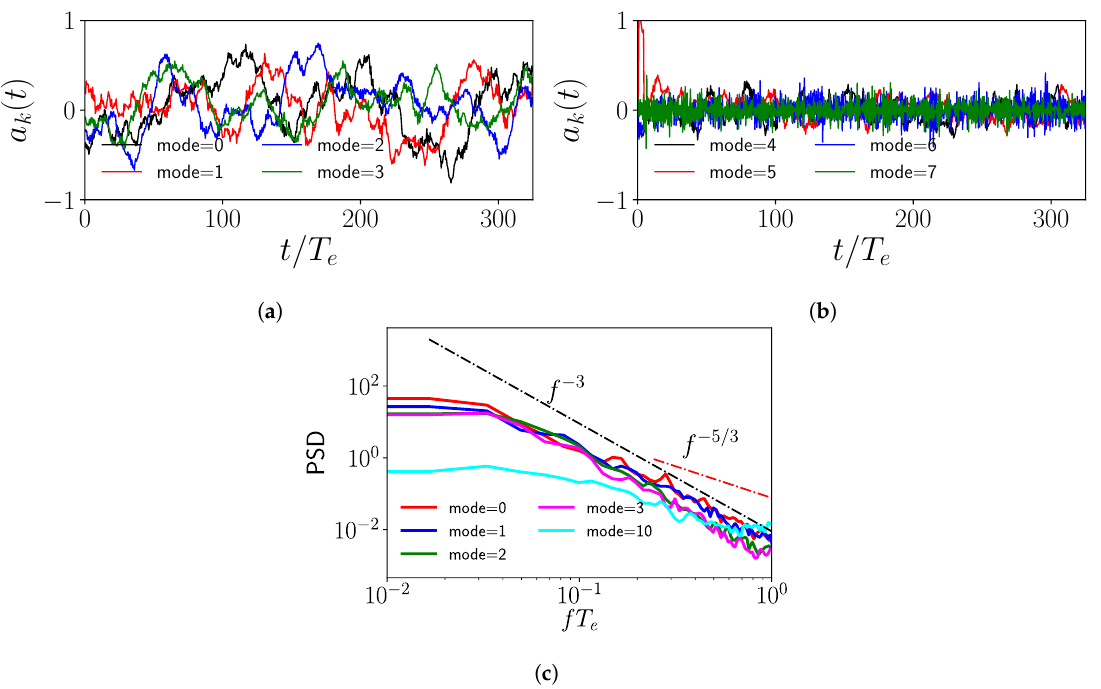
twice the standard deviation; ±